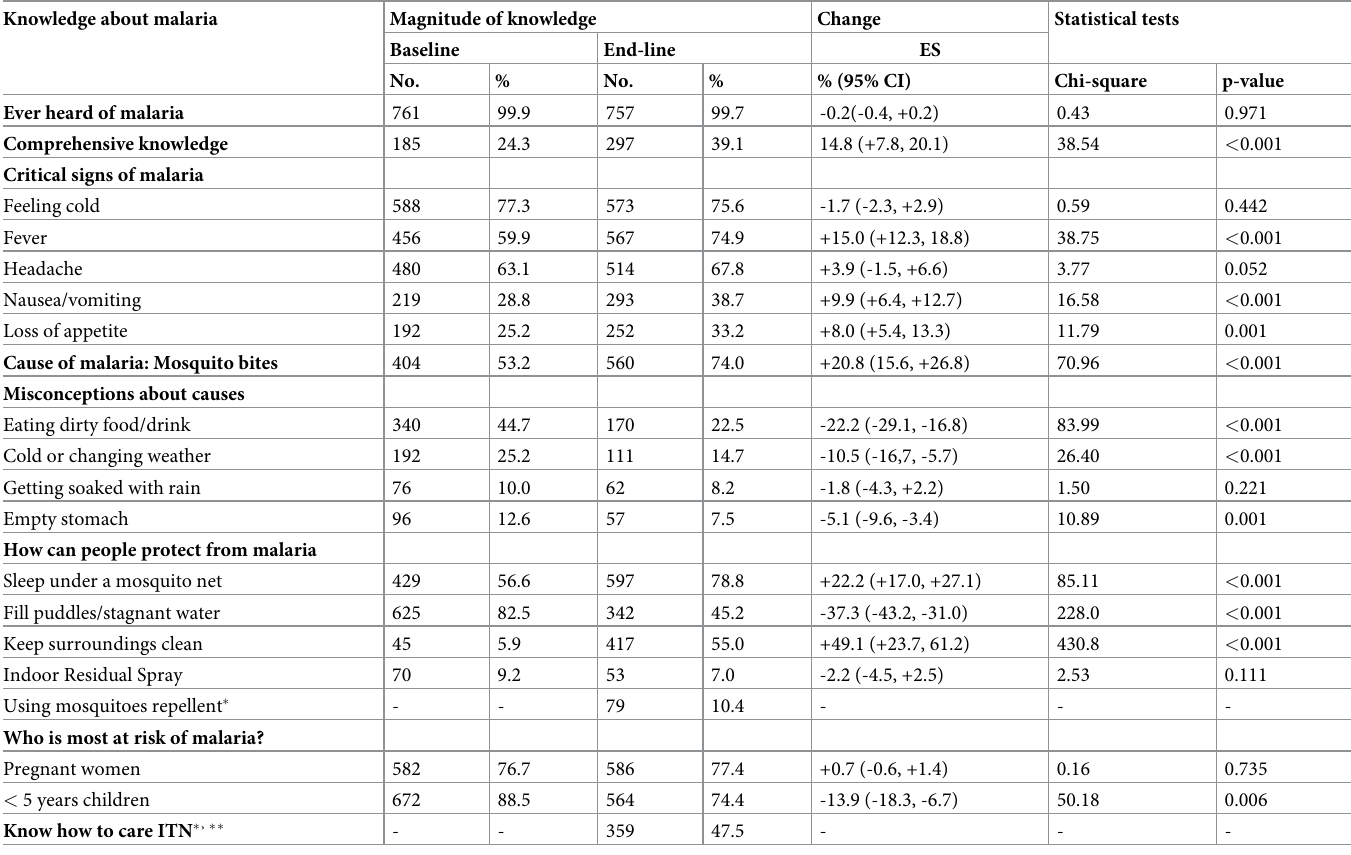
Table 4. Community knowledge of malaria, Jimma Zone, SBCC target districts, 2017–19 (Baseline = 762; End-line =